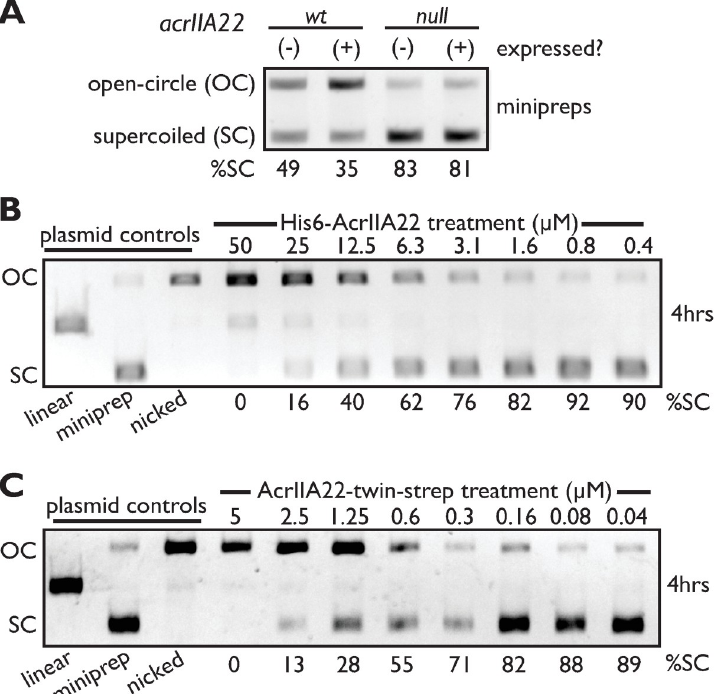
Fig 5. AcrIIA22 nicks supercoiled plasmids in vivo and in vitro. ( A ) Gel electrophoresis of plasmids purified from overnight E . coli cultures expressing either acrIIA22, or a null mutant with an early stop codon, or neither. Compared to the null mutant, more plasmid runs in a slowly migrating, OC conformation rather than SC plasmid with the wild- type acrIIA22 allele, suggesting that acrIIA22 may impact plasmid topology. %SC indicates the percentage of DNA in the SC form for each sample. ( B ) N-terminally His6-tagged AcrIIA22 nicks supercoiled plasmids in vitro. ( C ) C- terminally twin-strep-tagged AcrIIA22 nicks supercoiled plasmids in vitro with higher specific activity than shown in panel B (compare protein concentrations). Original, uncropped versions of images depicted in figure may be found in the Supporting information file, S1 Raw Images. OC, open-circle; SC, supercoiled.